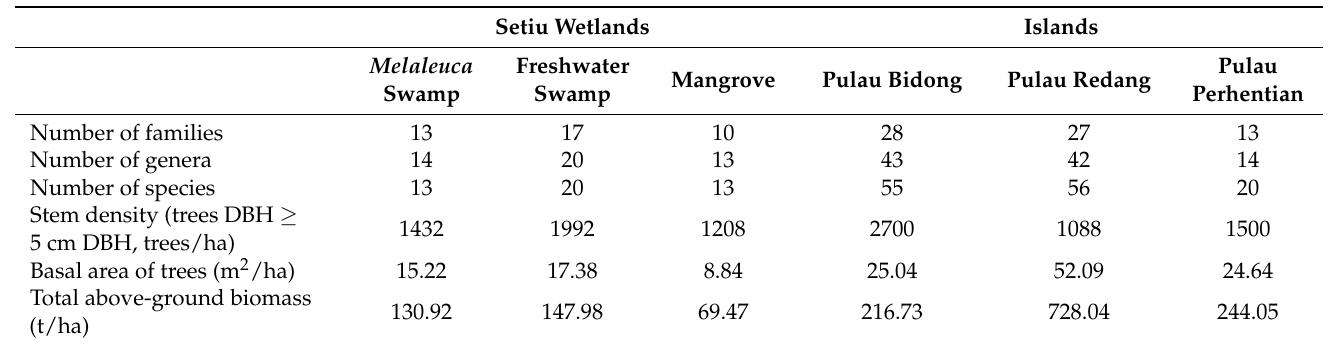
Table 1. Comparison of basic tree inventory metrics and the total above-ground biomass in each study site.